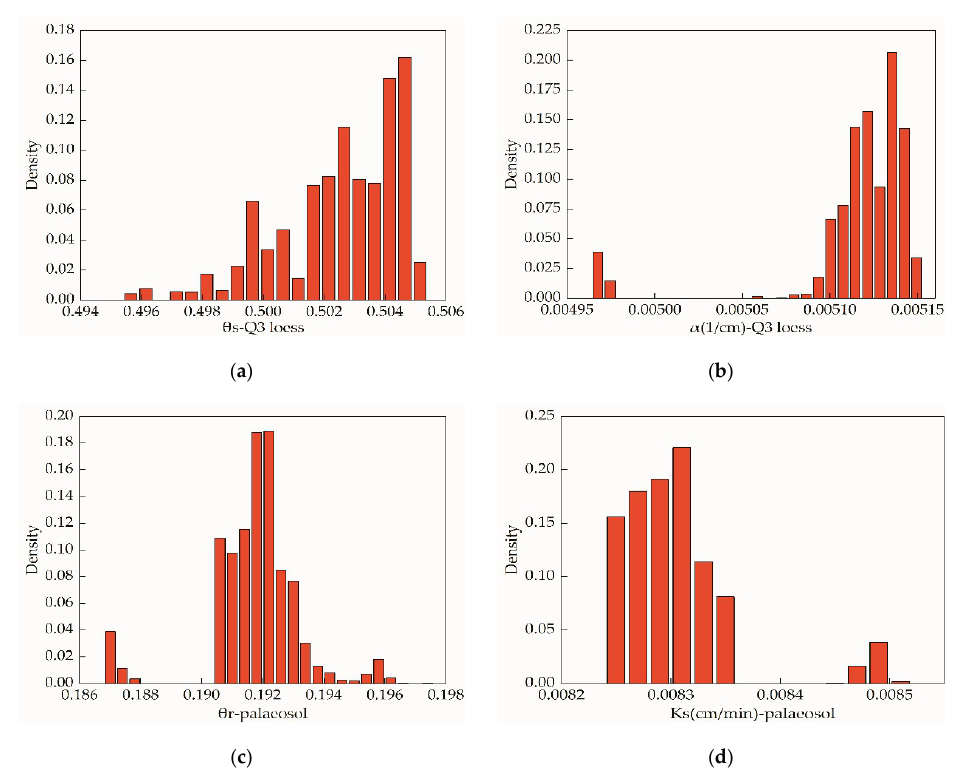
Figure 12. Histograms of the parameter posterior distribution derived from DREAM(zs) algorithm: ( a ) saturated volumetric water content of the Q3 loess (cm 3 cm − 3 ) ; ( b ) empirical parameters α of the Q3 loess (cm − 1 ); ( c ) residual volumetric water content of the palaeosol (cm 3 cm − 3 ); and ( d ) saturated hydraulic conductivity of the palaeosol (cm min ).